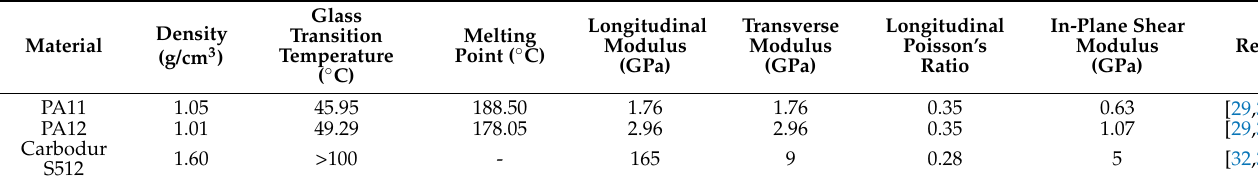
Table 1. Properties of the matrices and the reinforcement.